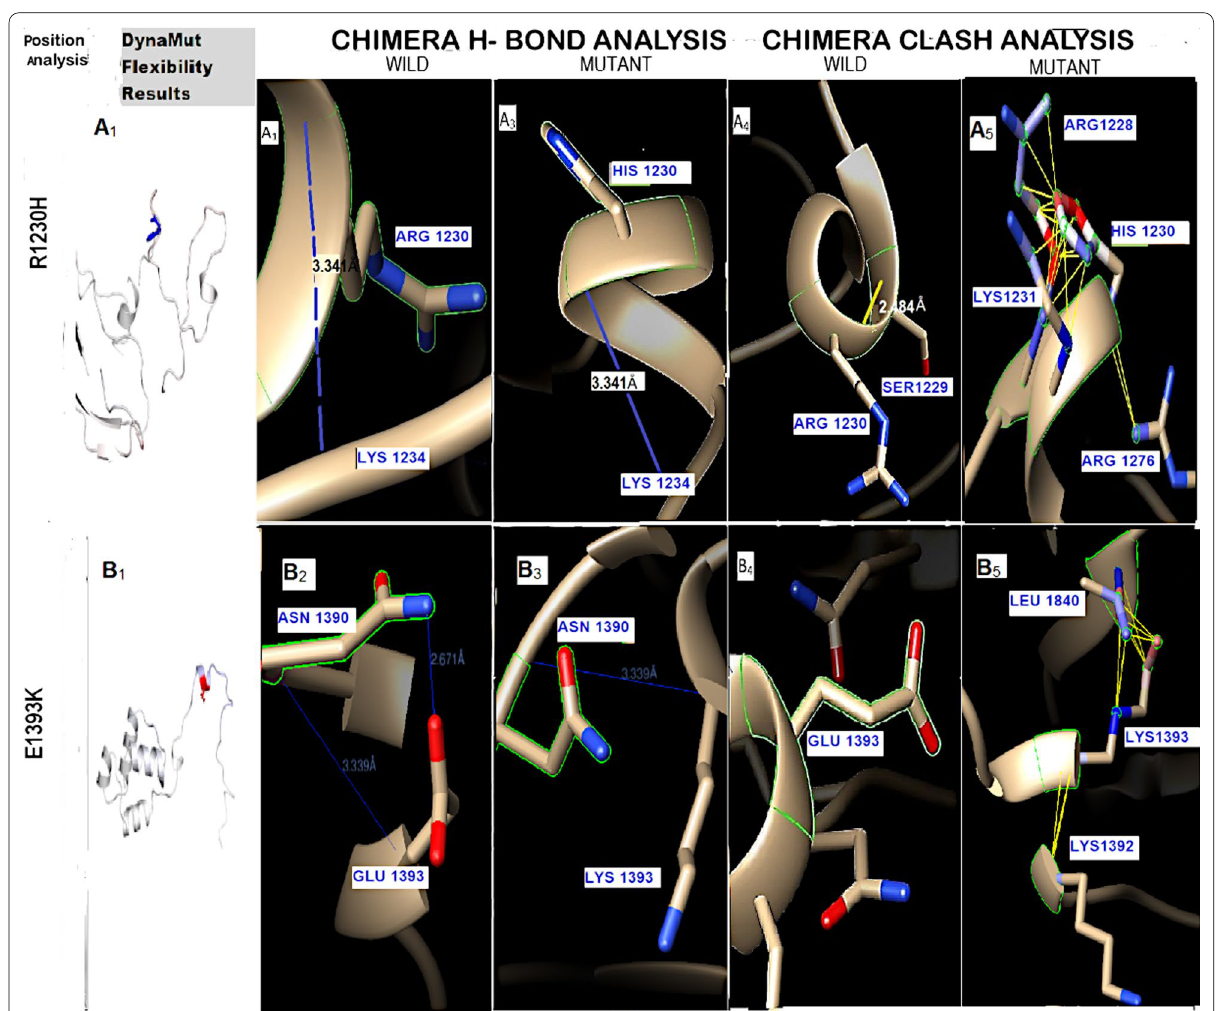
Fig. 2 Molecular Visualization and Analysis of Wild and Mutant positions: ( A 1 , B 1 ) resemble the DynaMut graphs flexibility results which reveal the SNP positions ( A 1 ) R1230H ( B 1 )E1393K where BLUE increase flexibility and RED decrease flexibility ( A 2 (1230), B 2 (1393))resemble the inter‑molecular H‑ bonding of wild residues ( A 3 (1230), B 3 (1393)) resemble the inter‑molecular H‑ bonding of Mutant residues ( A 4 (1230), B 4 (1393)) resemble the inter‑molecular Clashes of wild residues ( A 5 (1230), B 5 (1393)) resemble the inter‑molecular Clashes of Mutant